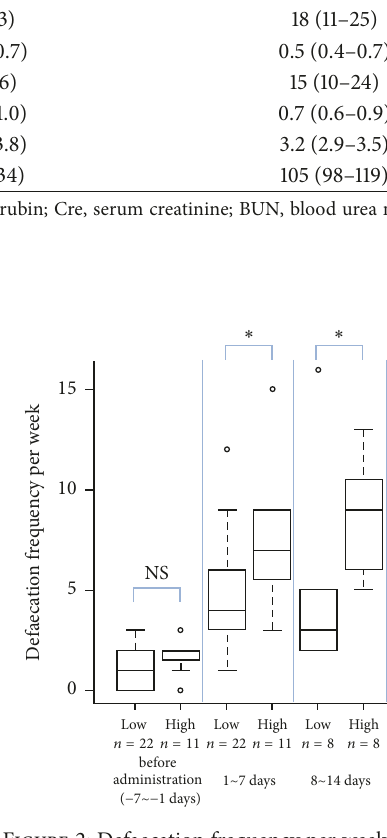
Figure 1: Box plot of defaecation frequency per week before and after Daikenchuto (DKT) administration. The box includes observations from the 25th to 75th percentile, and the horizontal line within the box represents the median value. ∗∗∗ indicates significance compared to values before DKT administration.